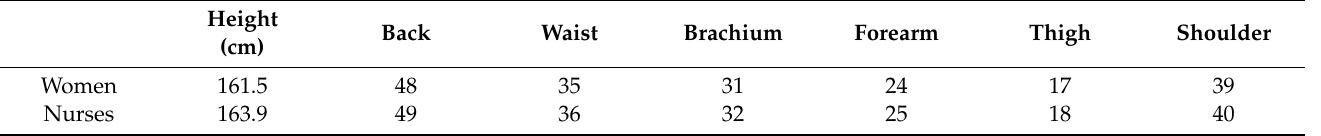
Table 2. Average measurements (in cm) of women